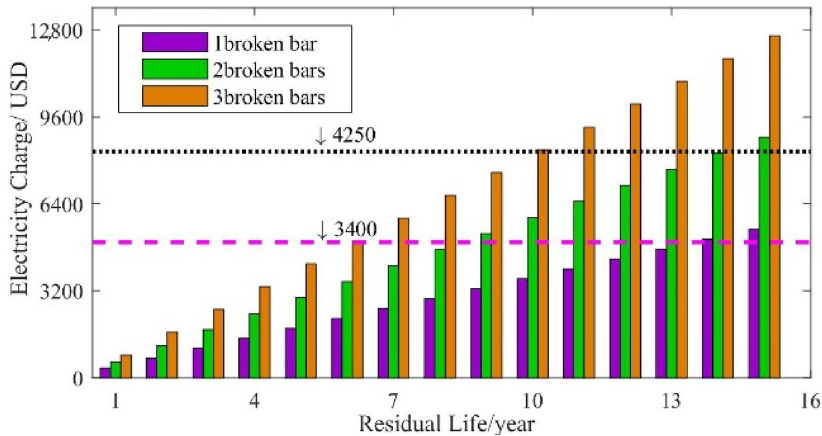
Figure 22. Extra electricity charges during the life period of the unit